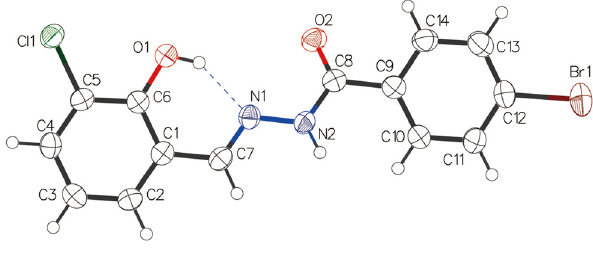
Table  : Fractional atomic coordinates and isotropic or equivalent isotropic displacement parameters (Å 